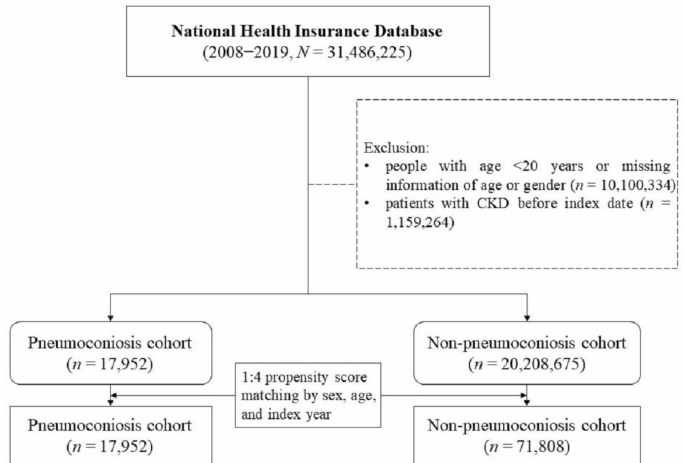
Figure 1. Flowchart of participants